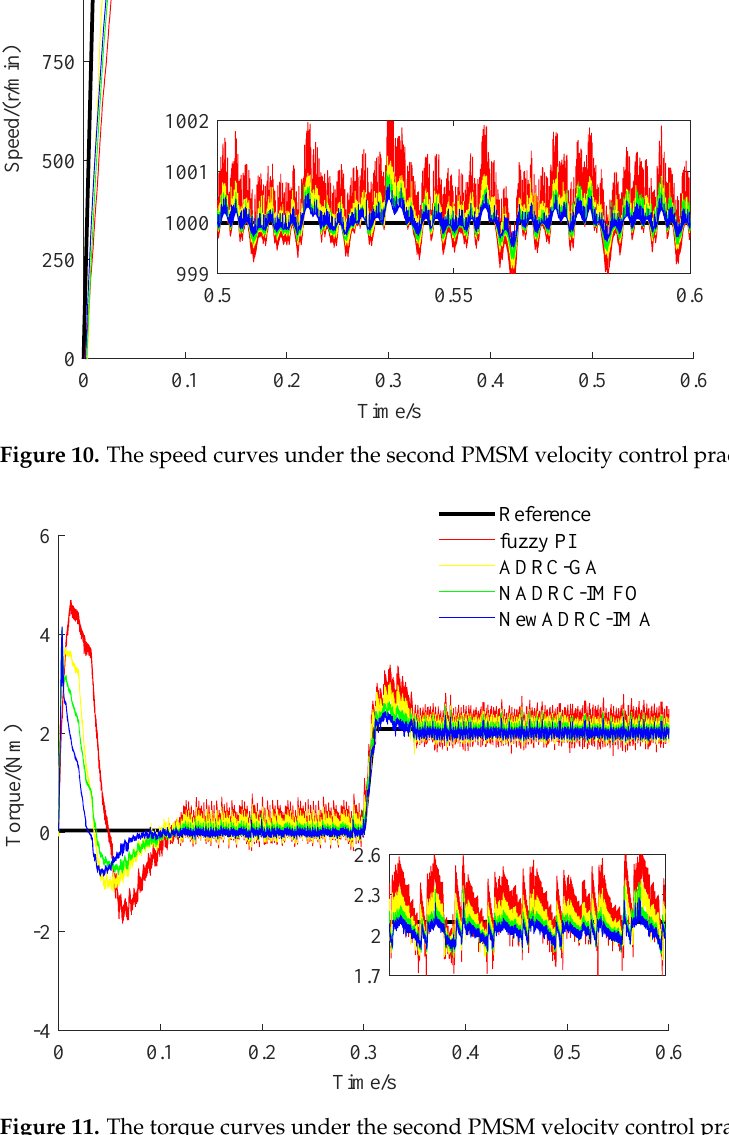
Figure 11. The torque curves under the second PMSM velocity control practical